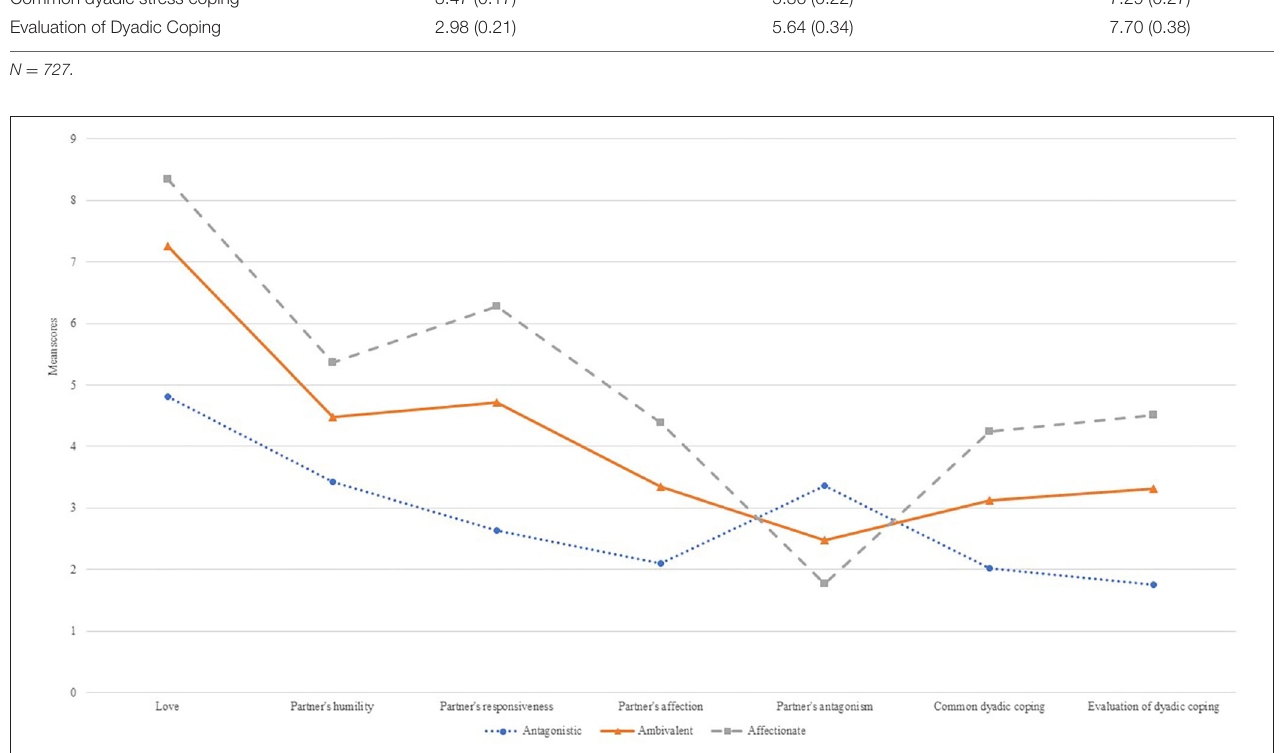
FIGURE 1 | Profiles of the selected three-profile